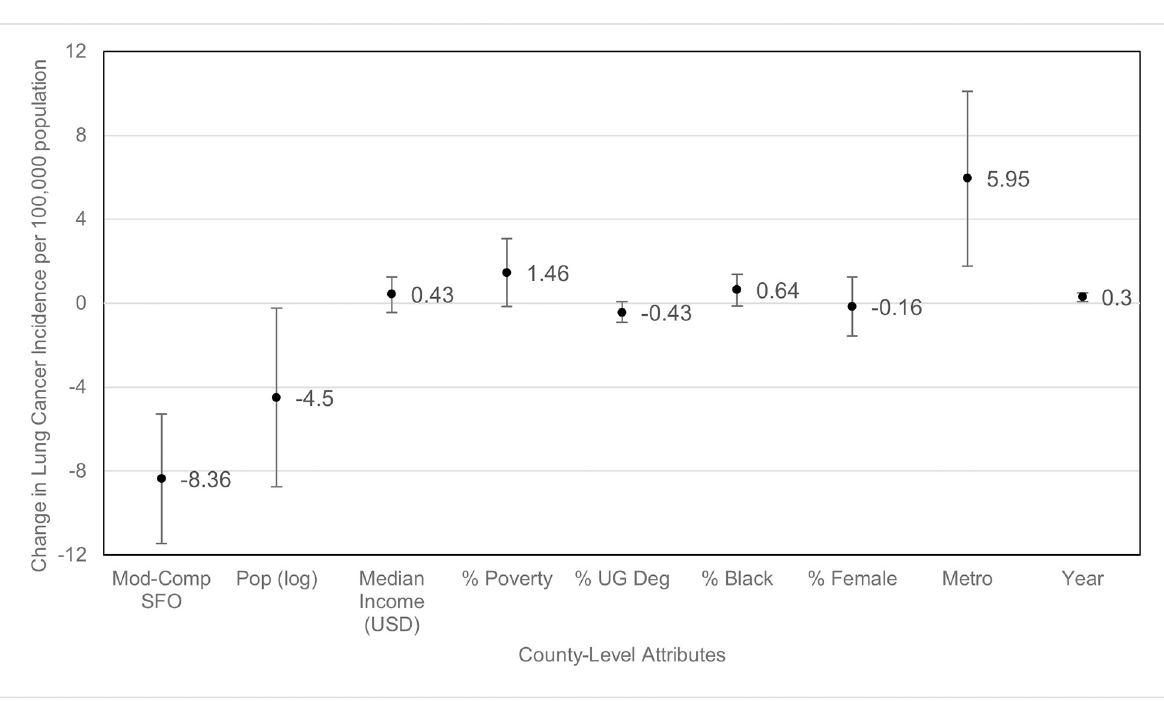
Fig 2. Change in lung cancer incidence by county-level attributes. Mod-Comp SFO = moderate-to-comprehensive smoke-free ordinance, pop (log) = population log, % UG Deg = percent with undergraduate degree. Circles represent estimated change in lung cancer incidence and bars represent 95% confidence intervals. “Moderate to comprehensive smoke-free ordinances” change is calculated relative to none or weak smoke-free ordinance counties. “Population (log)” change is calculated based on each 10% increase in population. For continuous predictor values, circles represent estimated change based on 1% increase in corresponding characteristic (e.g., for each 1% in poverty, the lung cancer incidence increases by 0.3%) except for “Median Income (USD)” which is estimated as change based on an increase of $1,000 and “year,” for which change is estimated based on an increase of 1 year. For “metro”, change is calculated as counties classified as metropolitan versus rural.